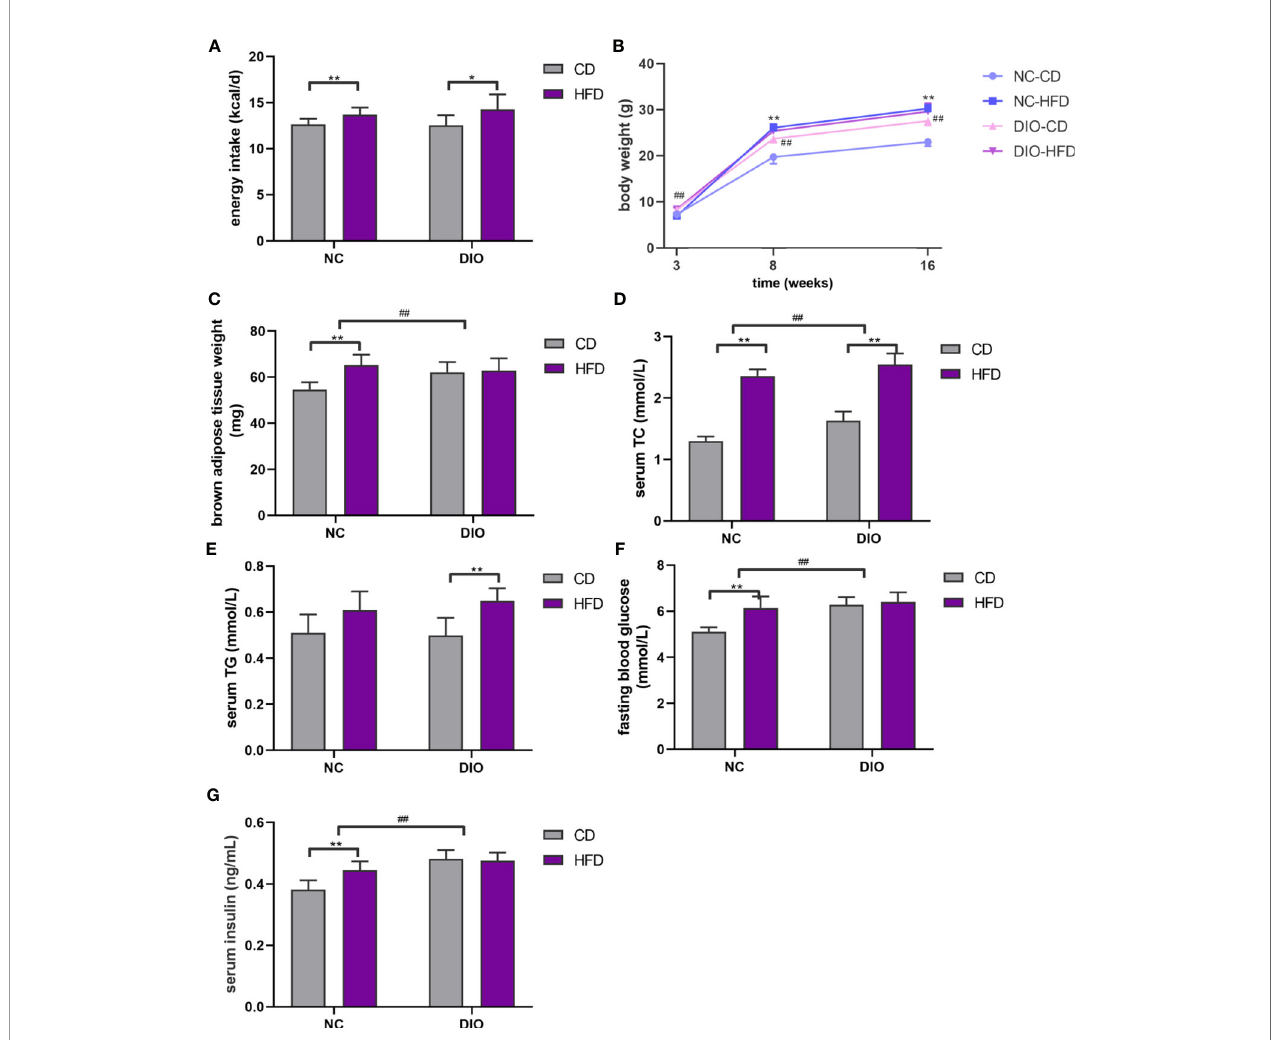
FIGURE 3 | Offspring characteristics. (A) Energy intake, (B) body weight, (C) brown adipose tissue weight (BAT), (D) serum total cholesterol (TC), (E) serum triglyceride (TG), (F) fasting blood glucose (FBG), (G) serum insulin. Values represent the mean ± SEM, n = 8 each group. P values represent signi fi cance in the main effect for each source of variation (diet or prenatal exposure) as calculated by two-way ANOVA: * P < 0.05, ** P < 0.01 offspring diet effect, ## P < 0.01 maternal diet effect. NC, normal control; DIO, diet-induced obesity; CD, control diet; HFD, high-fat